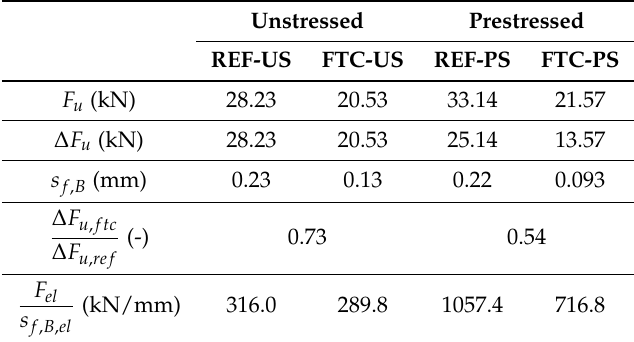
Table 1. Results obtained from lap-shear tests, both for unstressed and prestressed